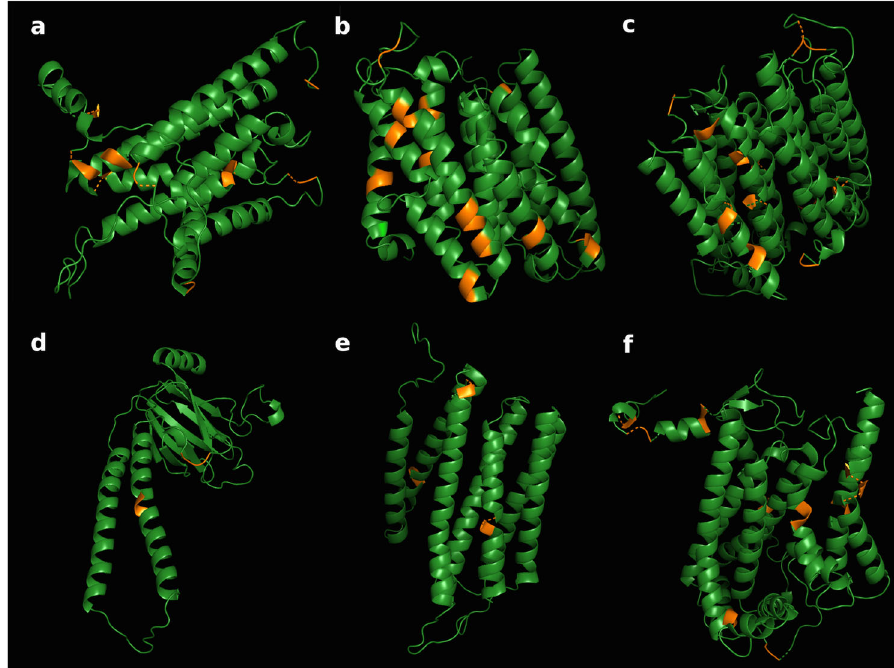
Fig. 6 Positive selection of amino acids in protein structure. Protein structure of LAI M2 proteins depicting putative positive selection (orange) in encoded A ND1, B ND2, C ND4, D COII, E COIII, and F Cytb. Structures are estimated with the ConSurf method 51 based on homologs of proteins in the UNIREF-90 database, and visualized using PyMOL. Amino acid changes under putative positive selection in LAI M2 as detected by PAML and FEL are colored in orange, with the majority of them residing in transmembrane